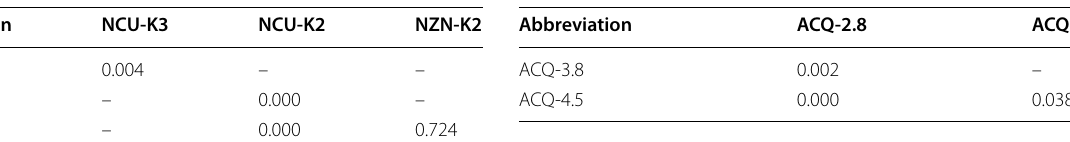
Table 6 Adjusted p value between each stake group